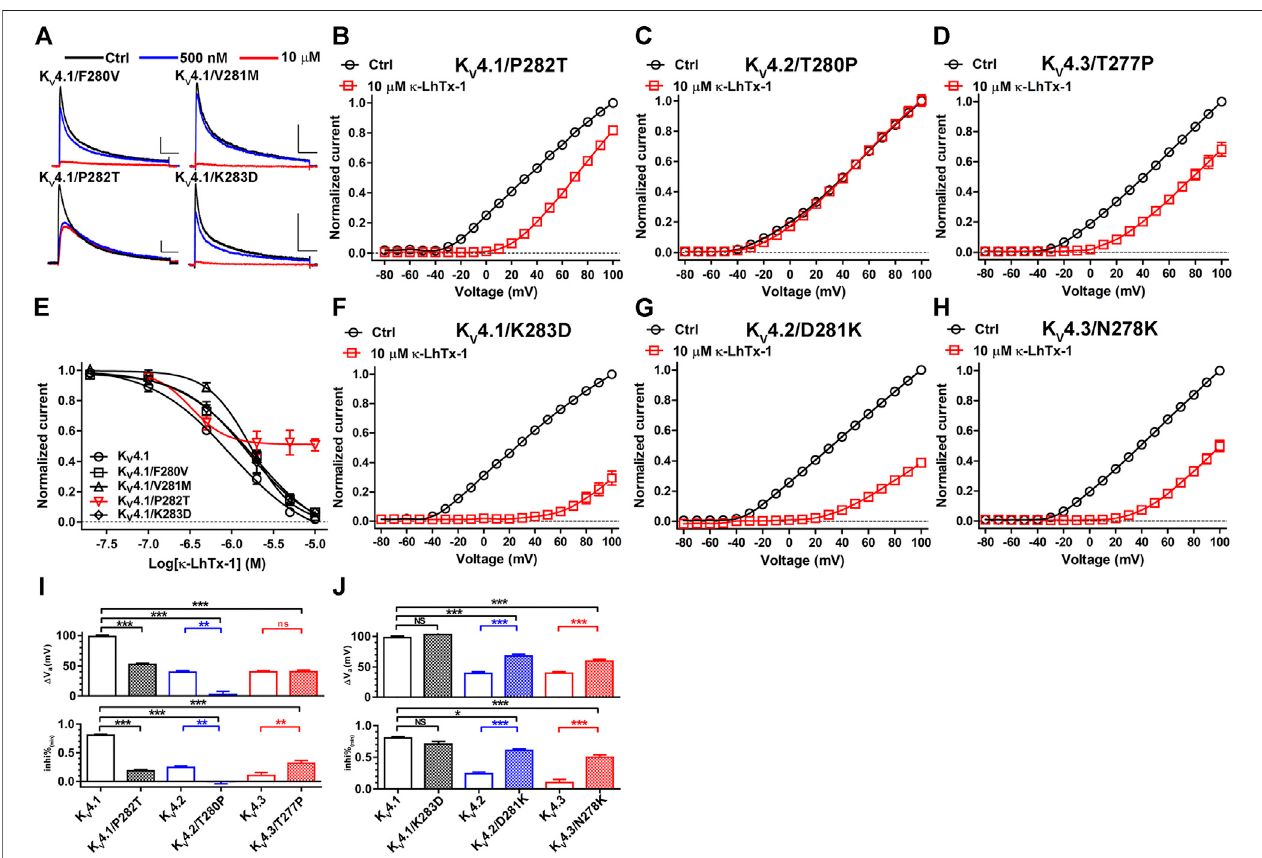
FIGURE 4 | Characterizing the key residues in the non-conserved S3b segment. (A) , Representative traces of κ -LhTx-1 inhibiting K V 4.1/F280V, K V 4.1/V281M, K V 4.1/P282TandKv4.1/K283Dmutants(n (cid:2) 5). (B – D) ,TheI-VcurvesofK V 4.1/P282T (B) ,K V 4.2/T280P (C) andK V 4.3/T277P (D) mutantsbefore(black)andafter(red) 10 μ M κ -LhTx-1 treatment (n (cid:2) 5 – 6). Currents at all voltages were normalized to the control current (before toxin treatment) at +100 mV in each group. (E) , The concentration-responsecurvesof κ -LhTx-1inhibitingK V 4.1/F280V,K V 4.1/V281M,K V 4.1/P282TandK V 4.1/K283Dmutantsat+30 mV(n (cid:2) 5).ThecurveforK V 4.1 was also included for comparison. (F – H) , The I-V curves of K V 4.1/K283D (F) , K V 4.2/D281K (G) and K V 4.3/N278K (H) mutants before (black) and after (red) 10 μ M κ -LhTx-1treatment(n (cid:2) 5 – 6). Currentsat allvoltageswerenormalizedtothecontrolcurrent(before toxintreatment) at+100 mVineach group. (I) and (J) ,Thestatistical diagram of the Δ V a and inhi% (min) valuesofwild-type K V 4 channels and mutants referred in this Figure, showing thatP282T mutation inK V 4.1, D281K mutation in K V 4.2, aswellasN278KmutationinK V 4.3dramaticallychangedchannel ’ svoltage-dependencephenotypeininhibition by κ -LhTx-1 (*, p < 0.05;**, p < 0.01; ***, p < 0.001;ns, not signi fi cantly different; ONE-WAY ANOVA; n (cid:2) 5 –